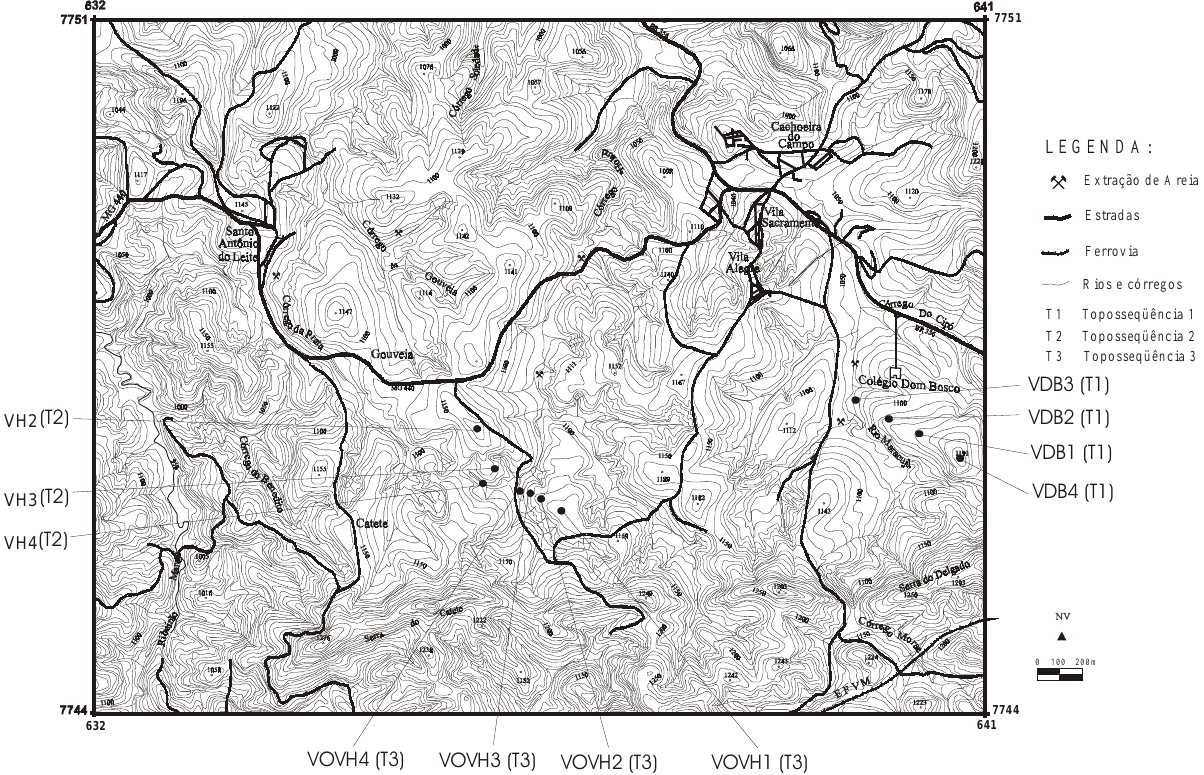
Figura 2. Mapa planialtimétrico da área investigada com as três toposseqüências assinaladas. Toposseqüência 1. VDB4 = alta vertente; VDB1 = meia vertente superior; VDB2 = meia vertente inferior; VDB3 = baixa vertente. Toposseqüência 2. VH2 = alta vertente; VH3 = meia vertente; VH4 = baixa vertente. Toposseqüência 3. VOVH1 = alta vertente; VOVH2 = meia vertente superior; VOVH3 = meia vertente inferior; VOVH4 = baixa